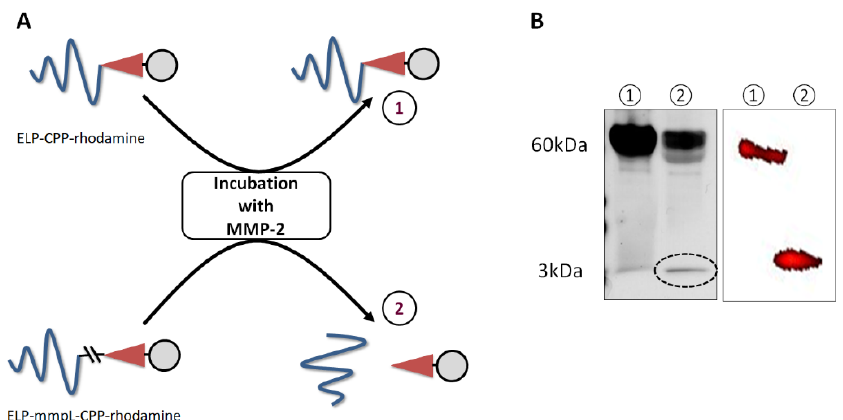
Figure 2. MMP-2 digestion of ELP-mmpL-CPP. ( A ) ELP-mmpL-CPP-rhodamine and ELP-CPP- rhodamine were incubated with MMP-2 for 4 h in ZnCl 2 buffer (pH 7). ( B ) MMP-2 incubation of the constructs produced ELP-CPP-Dox (63 kDa, upper band) and CPP-rhodamine (3 kDa, lower band). Left panel: silver-stained gel; Right panel: fluorescence-scanned gel. Dox: 6-maleimidocaproyl amide derivative of doxorubicin; mmpL: MMP substrate.